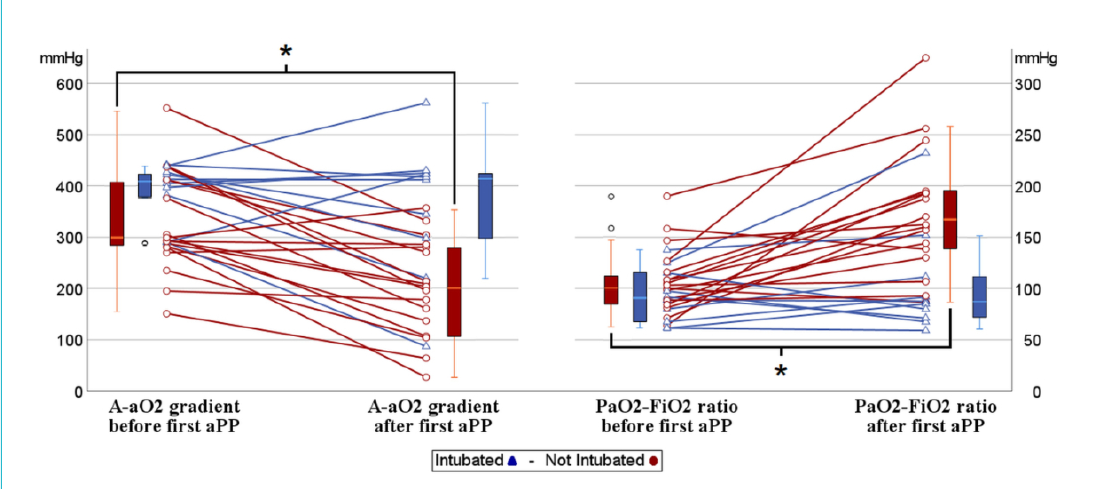
Figure 1: Individual changes in Aa-O 2 and PaO 2 /FiO 2 before and after the first aPP for patients who were ultimately intubated (in blue) or not (in red). Box plots for the groups of data are also reported. Aa-O 2 : alveolar- arterial gradient of oxygen; PaO 2 : arterial partial pressure of oxy- gen; FiO 2 : Inspired fraction of